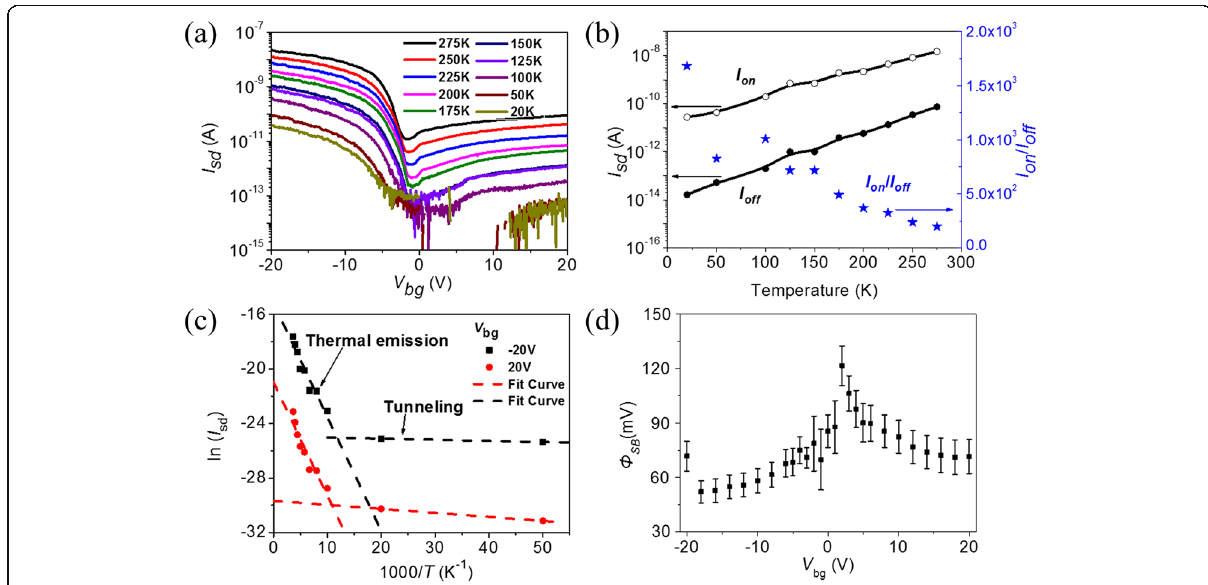
Fig. 4 Temperature-dependent electric properties of a p-type multi-layered MoTe 2 transistor. a Transfer characteristics of MoTe 2 transistor at V sd =1 V as a function of temperature. b On-current, off-current, and on-off current ratio as a function of temperature. c Arrhenius plot of the source-drain current as a function of temperature at V sd =1 V and V bg = − 20 V and 20 V, respectively. d Maps of effective Schottky barrier heights Φ SB as a function of back-gate